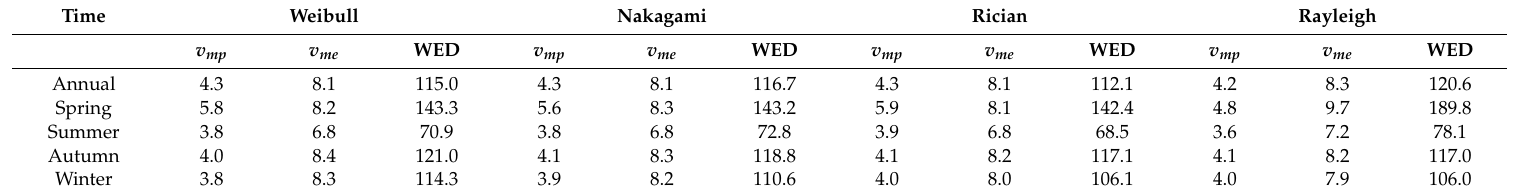
Table 11. Annual and seasonal wind potential assessment.